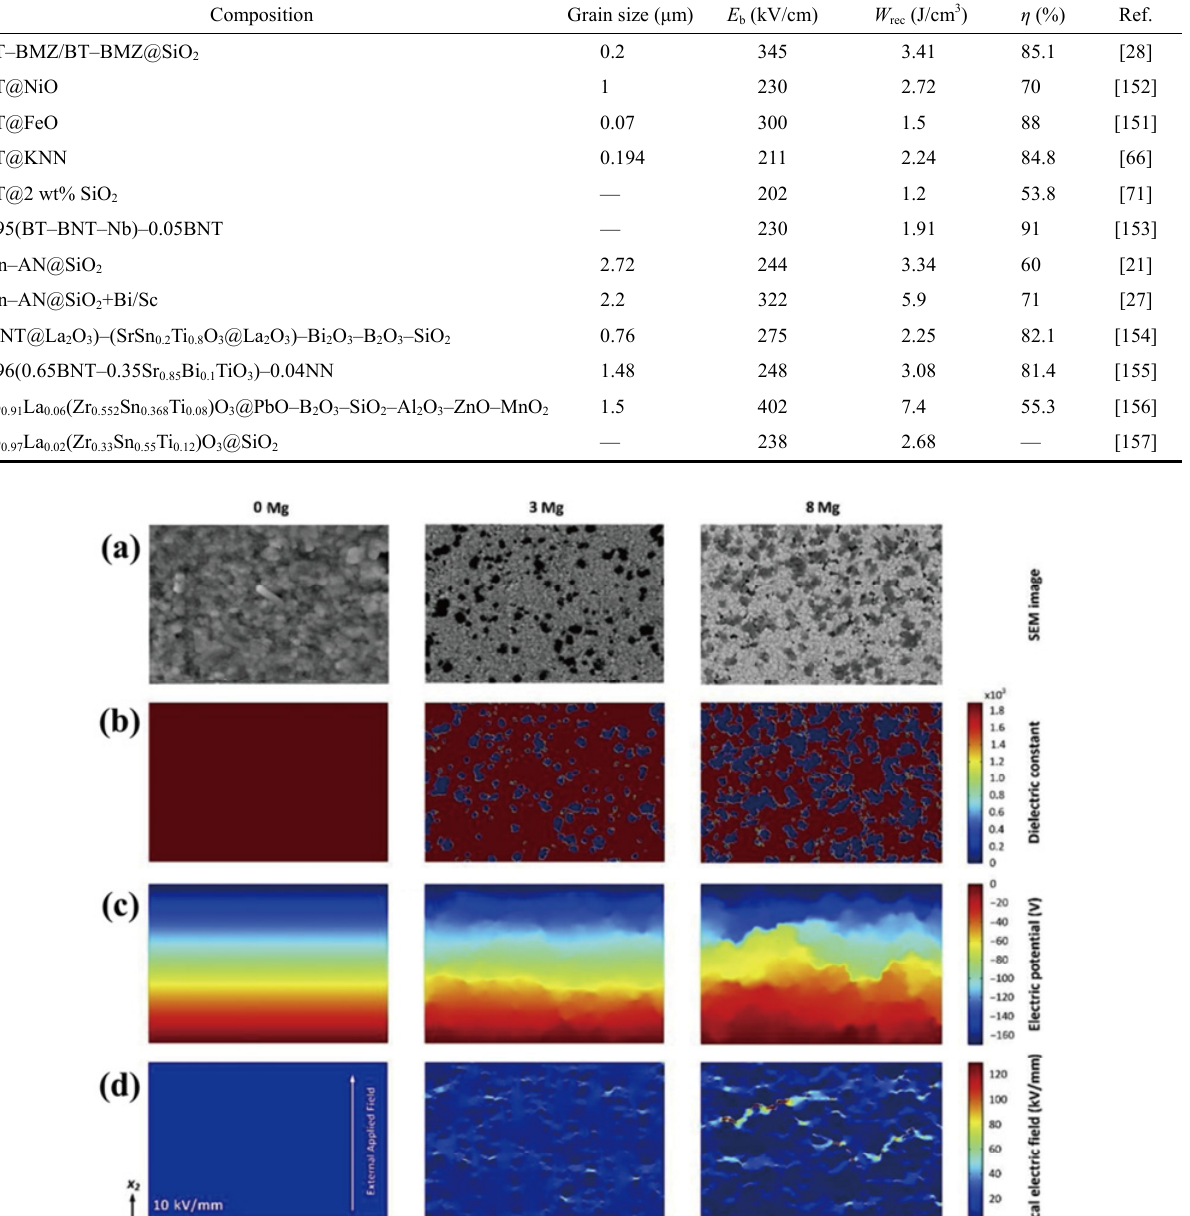
Table 3 Energy storage performance of ceramics with core–shell structures